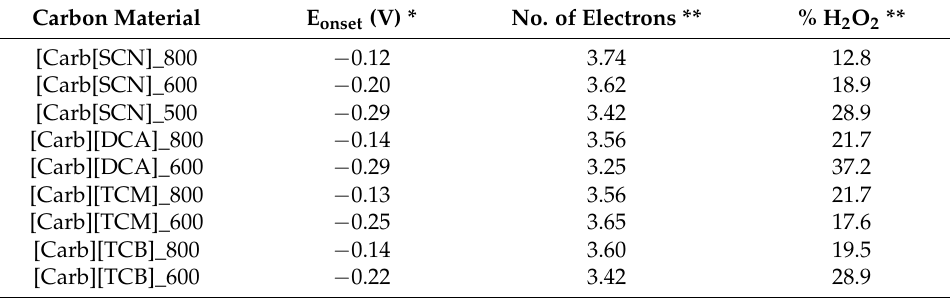
Table 3. The electrochemical properties of the carbon